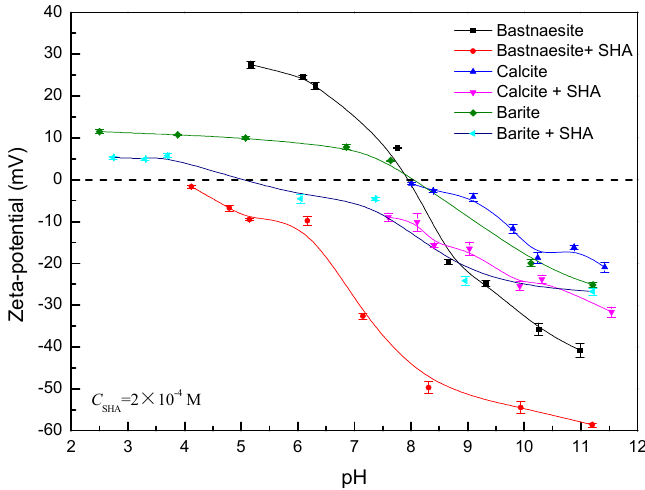
Figure 4. Zeta-potential of bastnaesite, calcite, and bariteas a function of pH in the absence and presence of SHA.